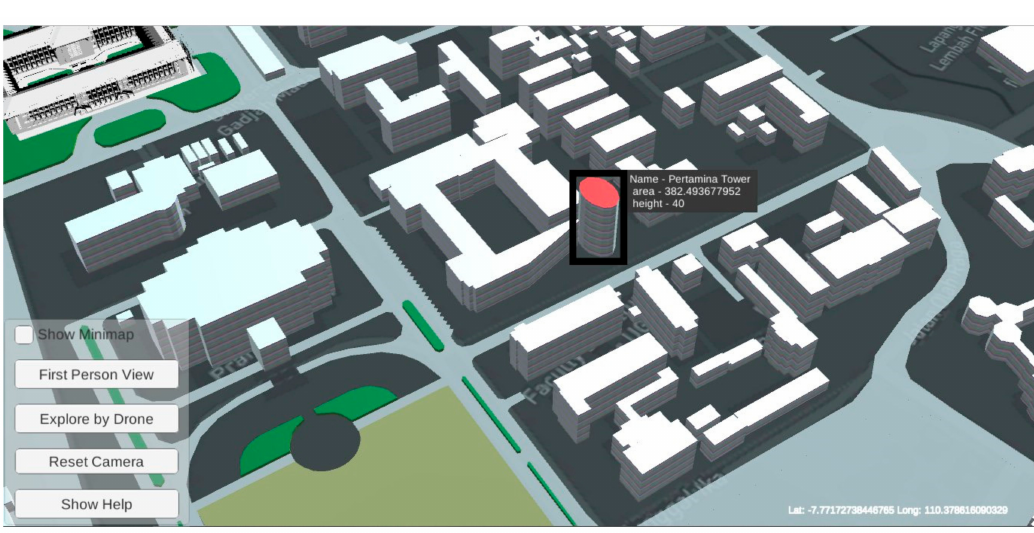
Figure A2. Screenshot of FPV navigation.